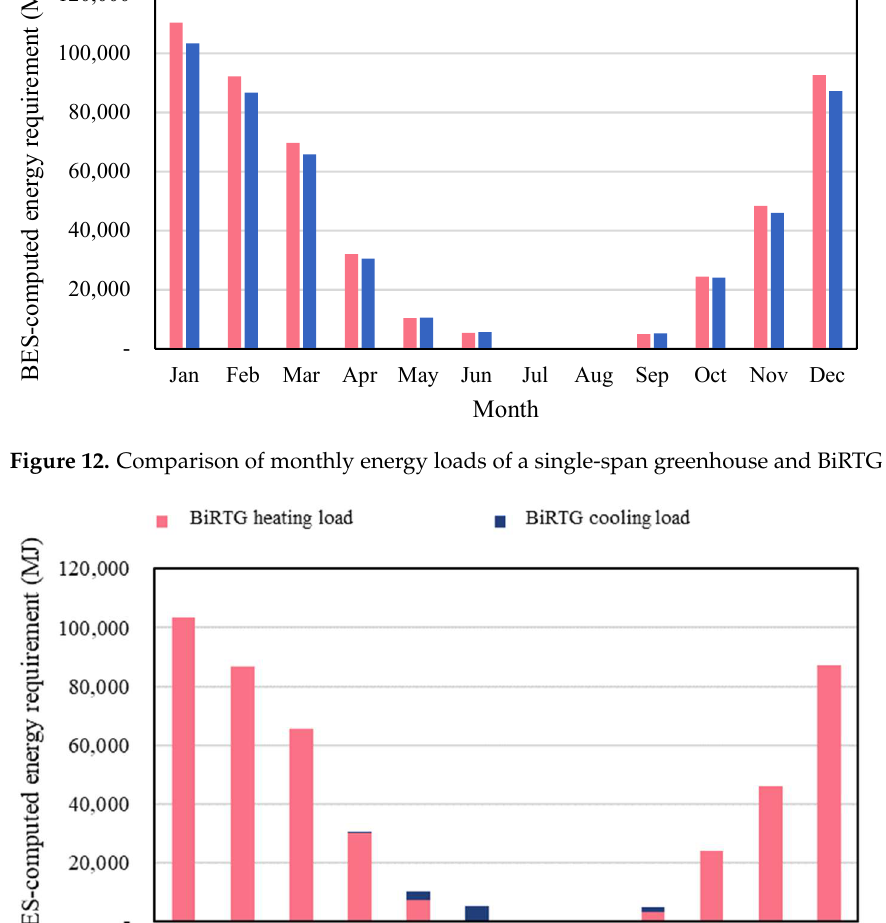
Figure 12. Comparison of monthly energy loads of a single-span greenhouse and BiRTG with crop.